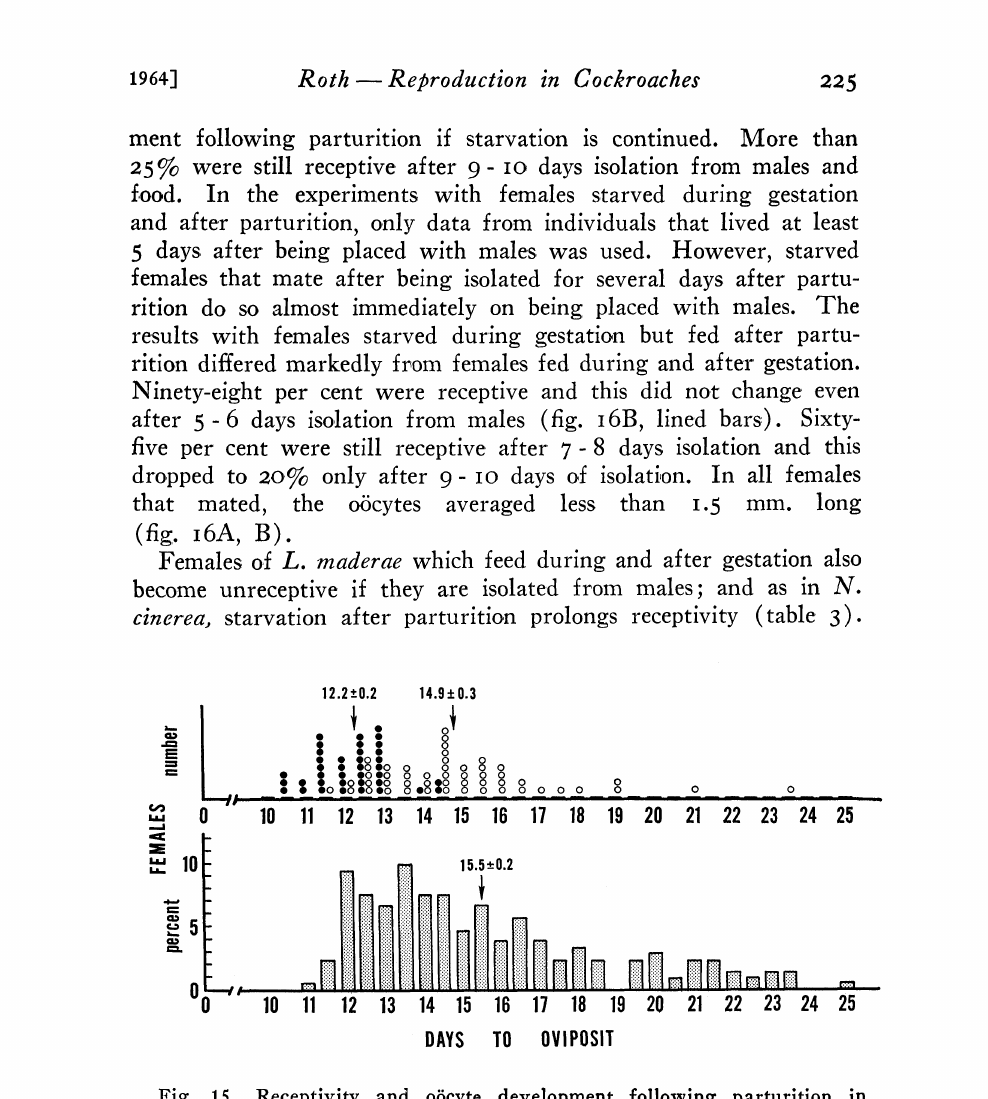
Fig. 15. Receptivity and ofeyte development following parturition in N. cinerea starved during gestation. Top" Females exposed to males and food after parturition. Solid circles receptive females. Open circles non-receptive females. Each circle represents one female. Days to oviposit calculated from time of exposure to food. Bottom" Females that were not exposed to males after parturition. (N 213). Days to oviposit calculated from time of parturition; females were given food within a day after giving birth. Numbers above the arrows indicate the average number of days + standard errors taken to oviposit by the various groups of